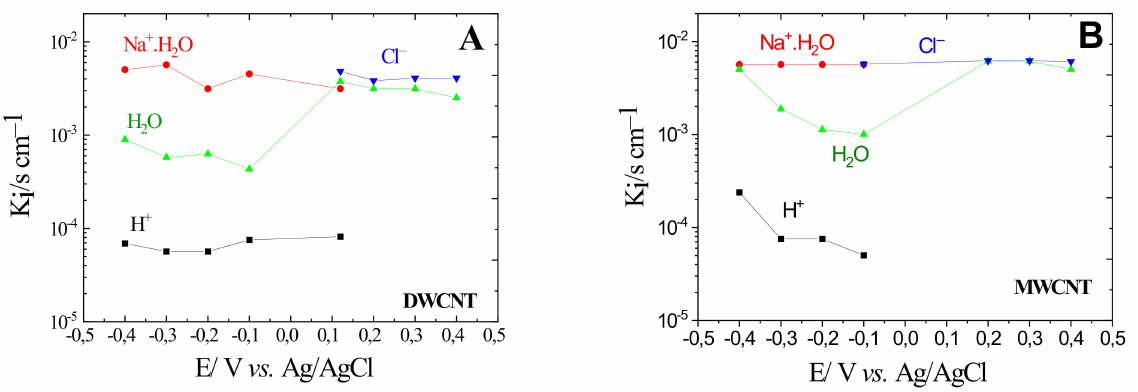
Figure 5. Kinetic constants of interfacial transfer, K i , DWCNT ( A ), MWCNT ( B ) estimated from the fitting of the AC-electrogravimetric data and measured in aqueous 0.5M NaCl. Finally, the H + ion is the slowest species at cathodic potentials for DWCNT and MWCNT films (Figure 5A,B) showing a similar order of magnitude of K i values, which is coherent with their substantially lower concentration in the